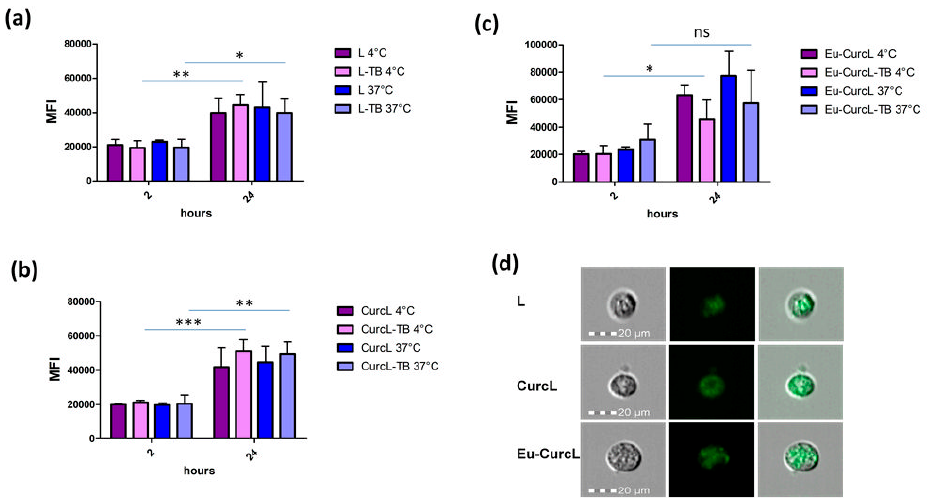
Figure 4. Uptake of empty liposomes ( a ), Curc-liposomes ( b ), Eu-Curc-liposomes ( c ) by Caco-2 cells. Caco-2 cells were incubated with NBD-PC-labelled liposomes either at 4 ◦ C for 15 min and then at 37 ◦ C or at 37 ◦ C for all the experiment duration. At the end of each incubation time (either 2 h or 24 h), cells were either analyzed as such (cell-associated liposomes) or after TB treatment (internalized liposomes). Data are shown as the mean ± SD of four replicates for each condition. * p < 0.05; ** p < 0.01; *** p < 0.001. ns: not significant. ( d ) The cells exemplificative of the condition at 37 ◦ C for 24 h with TB are shown as brightfield images (left column), fluorescence channel (middle column), and merge (right column).